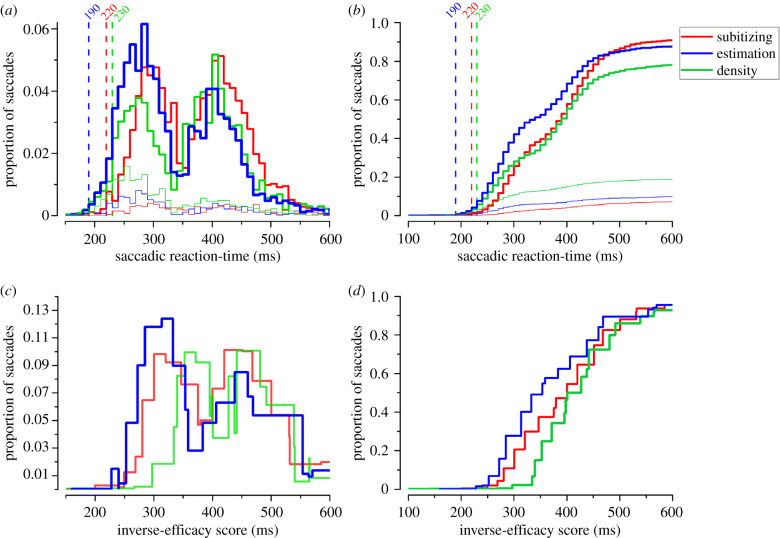
Saccadic reaction times. (a) Reaction-time histograms of correct (thick lines) and incorrect (thin lines) saccades for the subitizing (red), estimation (blue), and density (green) ranges. Dashed vertical lines refer to the minimum saccadic reaction-time for each range for reliably correct responses. (b) Cumulative sum of the proportion of saccades as a function of saccadic reaction-time. (c) Proportion of saccades as a function of the inverse-efficiency score (defined as the saccadic reaction-times divided by accuracy). (d) Cumulative sum of the proportion of saccades plotted as a function of the inverse-efficiency score. For visualization purposes 20-ms bins were used for the inverse-efficiency score plots.